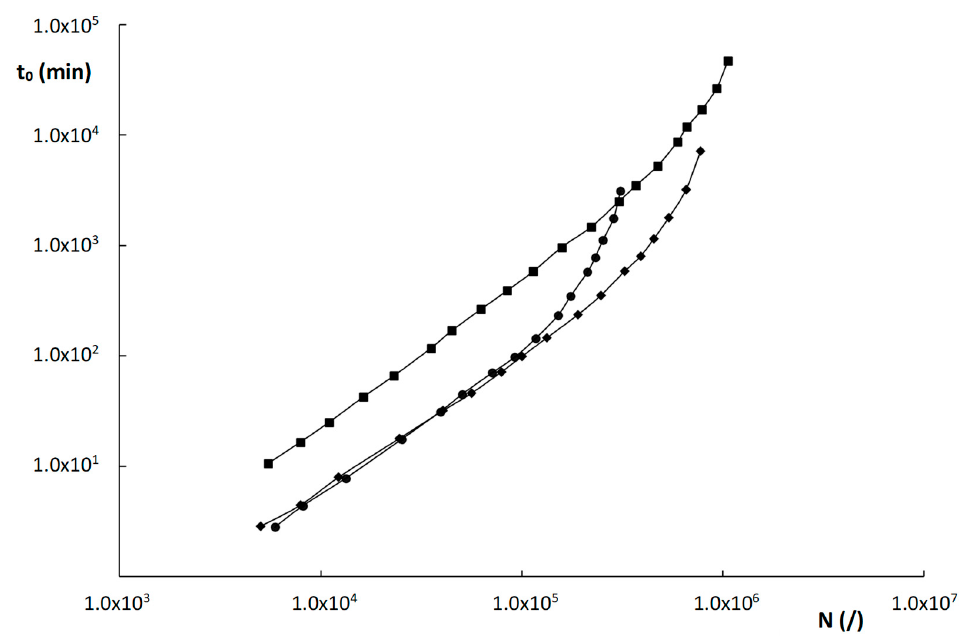
Figure 3. Plate height curves of H versus u i obtained on the ( a ) poly(SPE-co-EDMA) monolithic